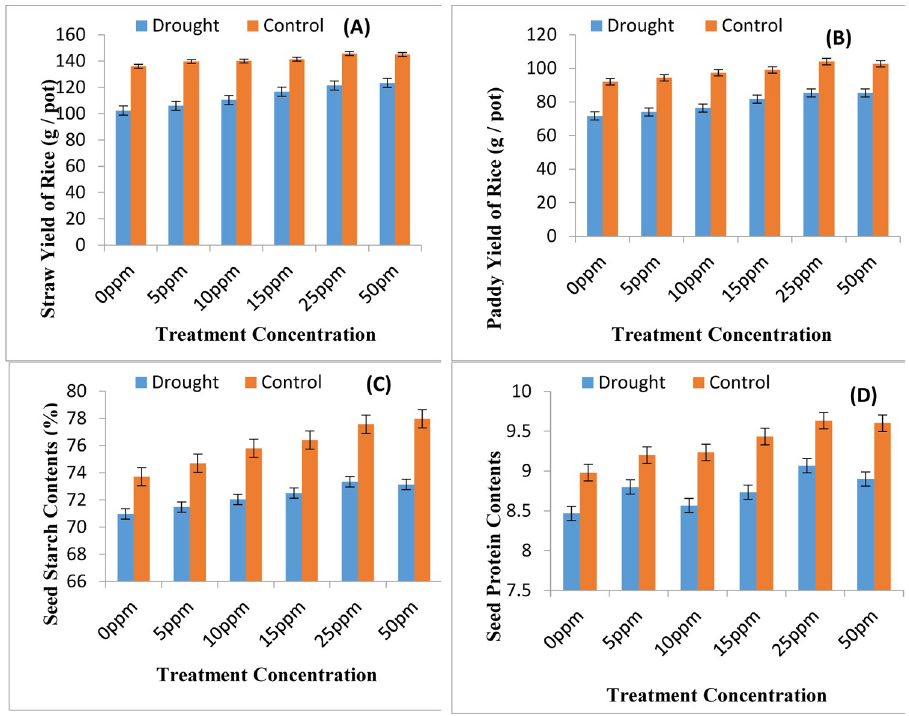
Fig 2. Yield attributes of rice plants. (A) Straw yield of rice (B) paddy yield of rice (C) seed starch contents and (D) seed protein contents as affected by various regimes of ZnONPs under water scarce and well irrigated environment (mean ± SE; n = 3).